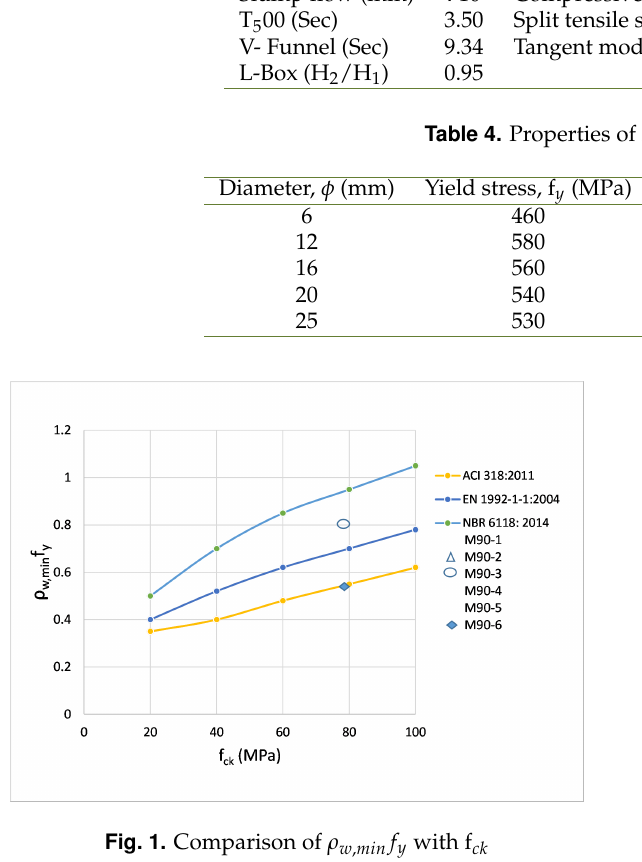
Fig. 1. Comparison of ρ w , min f y with f